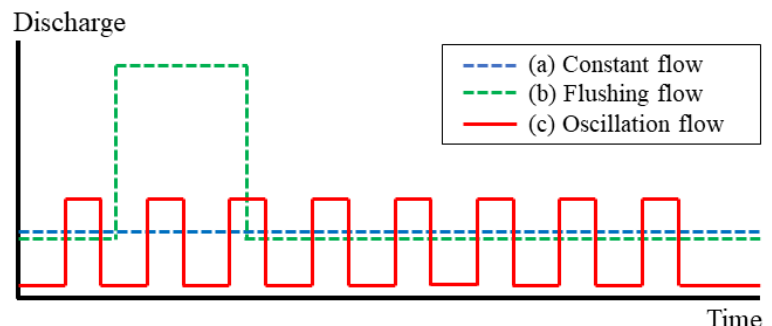
Figure 3. Concept of oscillation flow.